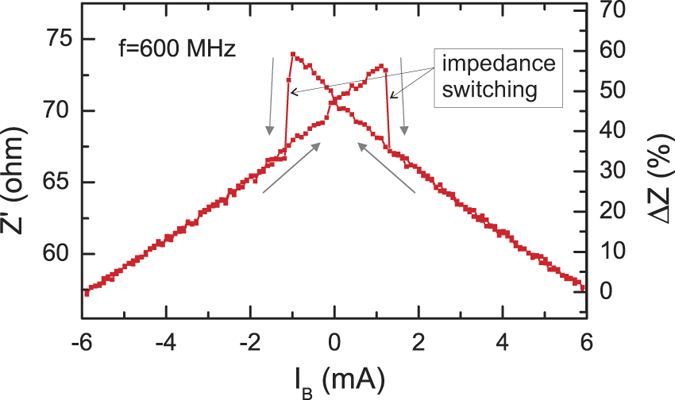
Experimental dependence Z′(IB) at f = 600 MHz.